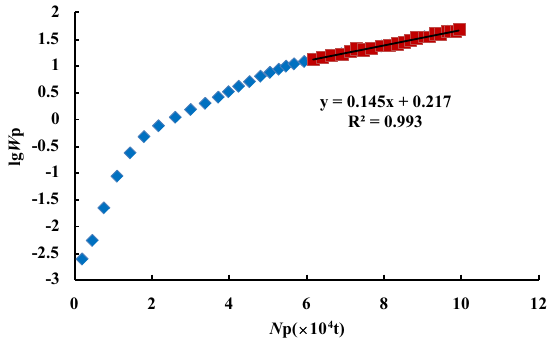
Fig. 4 Water flooding characteristic curve of M